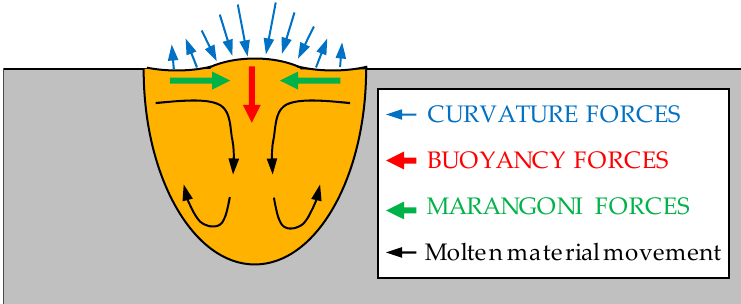
Figure 3. Material movement due to the surface and buoyancy forces.